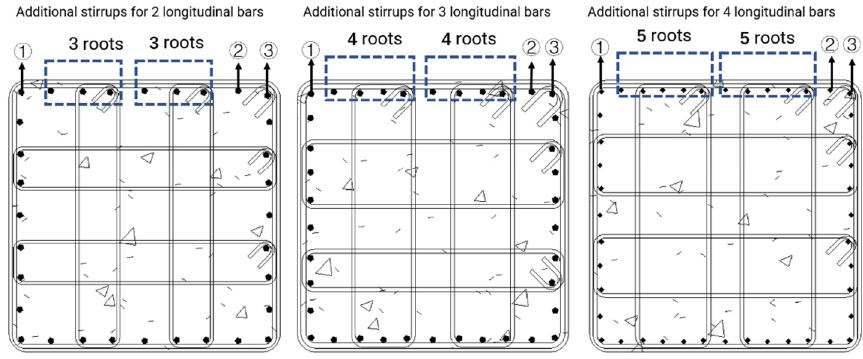
Figure 7. Additional stirrup arrangement rules.